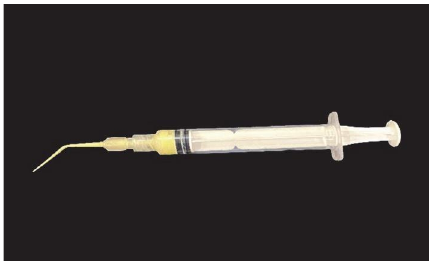
F IGURE 1: Modi fi ed disposable